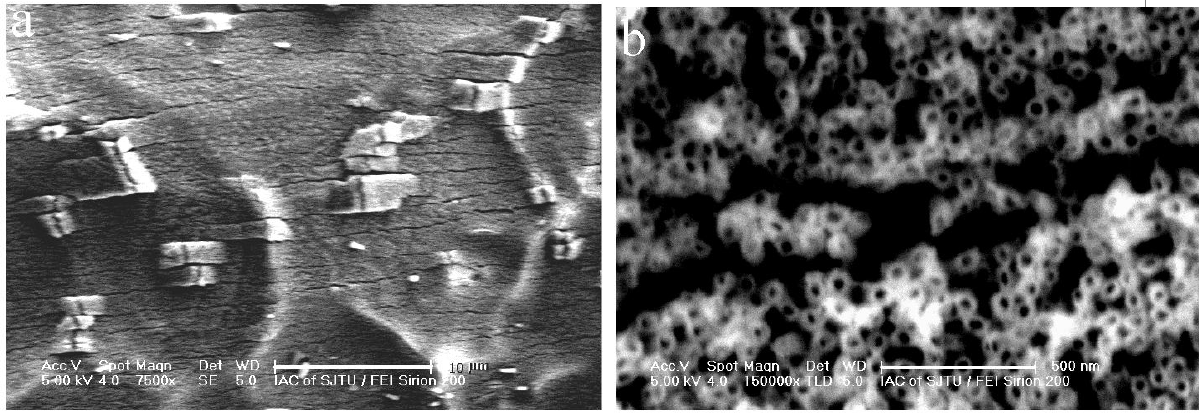
Figure 7. Top view images of the Ti-Ni-O nanotubes after five cycles of bending tests of the nanotube-coated shape memory alloy substrate: ( a ) low magnification image of the microcracks induced in the nanotube array film; ( b ) high magnification image of the crack